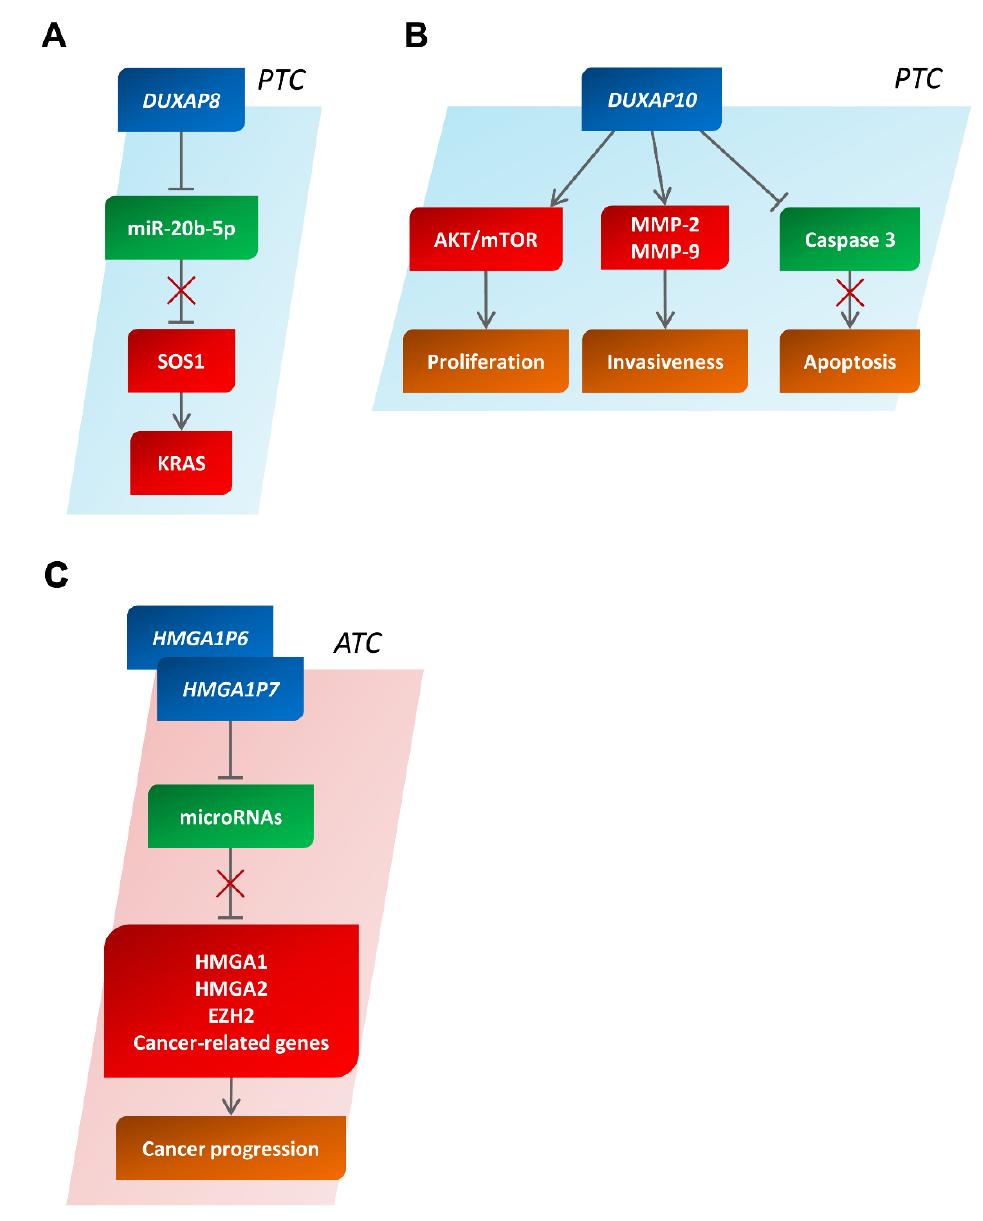
Figure 6. The involvement of pseudogenes in the biology of human thyroid carcinomas. Schematic representation showing the functions of DUXAP8 ( A ) and DUXAP10 ( B ) in papillary thyroid carci- nomas and of HMGA1P6 and HMGA1P7 ( C ) in anaplastic thyroid carcinomas. In red and in green, the partners with an oncogenic or anti-oncogenic behavior are reported, respectively. PTC, papillary thyroid carcinoma; ATC, anaplastic thyroid carcinoma.